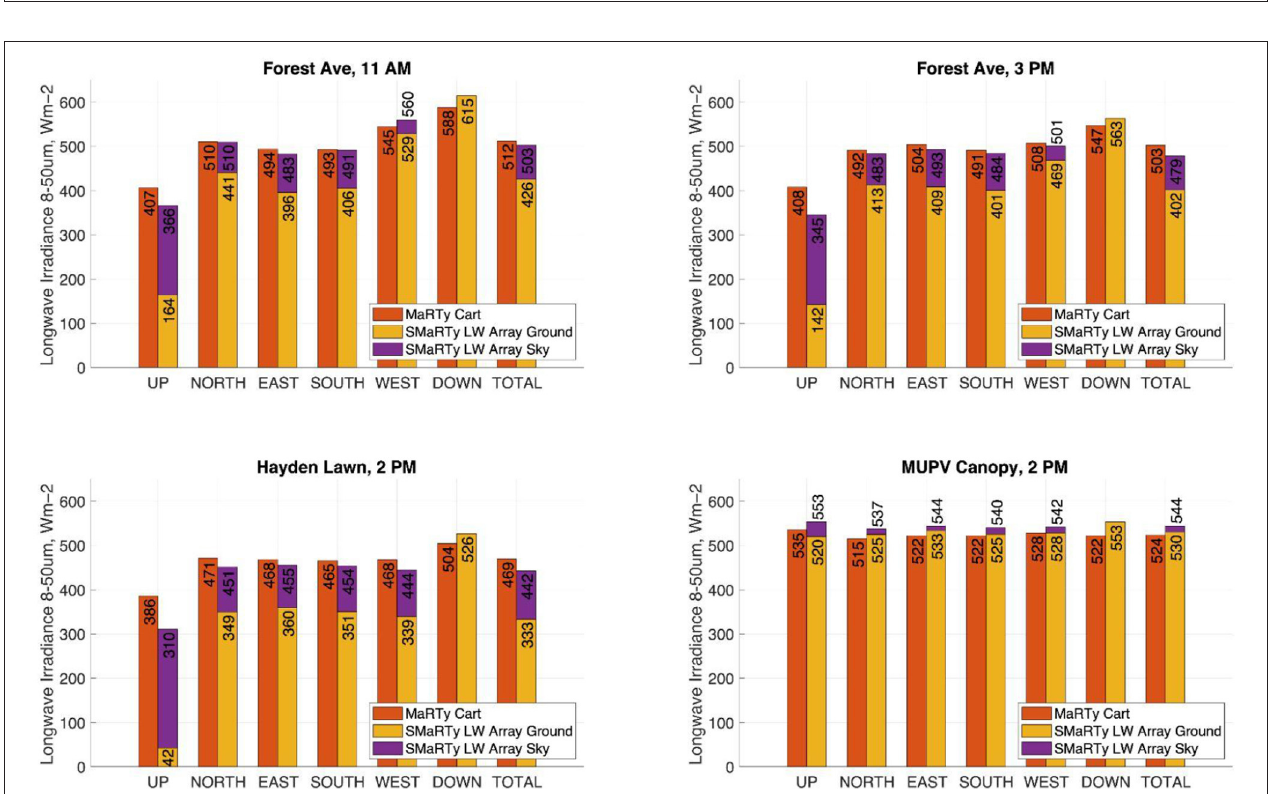
FIGURE 9 | Longwave radiation, W · m − 2 , measured at 11 am and 3 pm at Forest Ave by the COOR, and at 2 pm at the Hayden Lawn and at the MUPV Canopy. Planar Irradiance values are from each direction and the overall average, from the MaRTy cart (left bar) and the SMaRT-SL array (right bar). The SMaRT data is broken into sky and ground components by utilizing its greater degree of